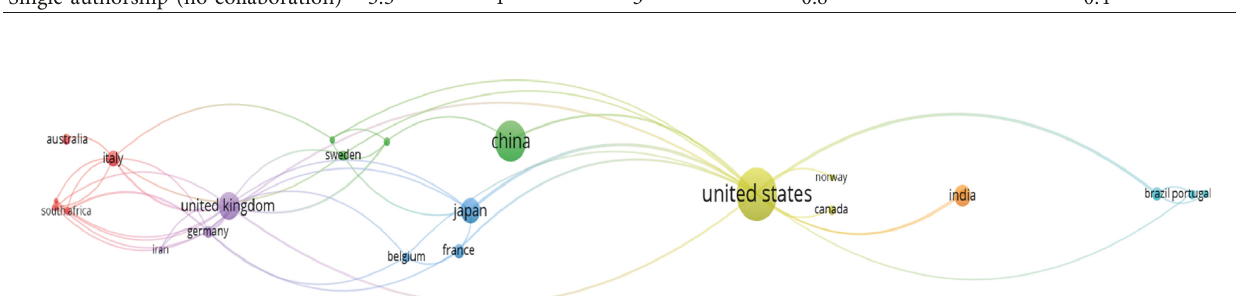
Figure 1: Coauthorship by country.